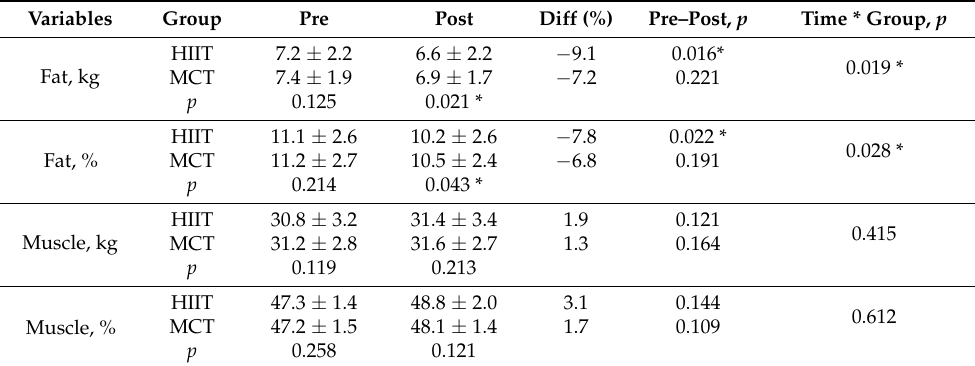
Table 4. Changes in body composition between groups according to training.